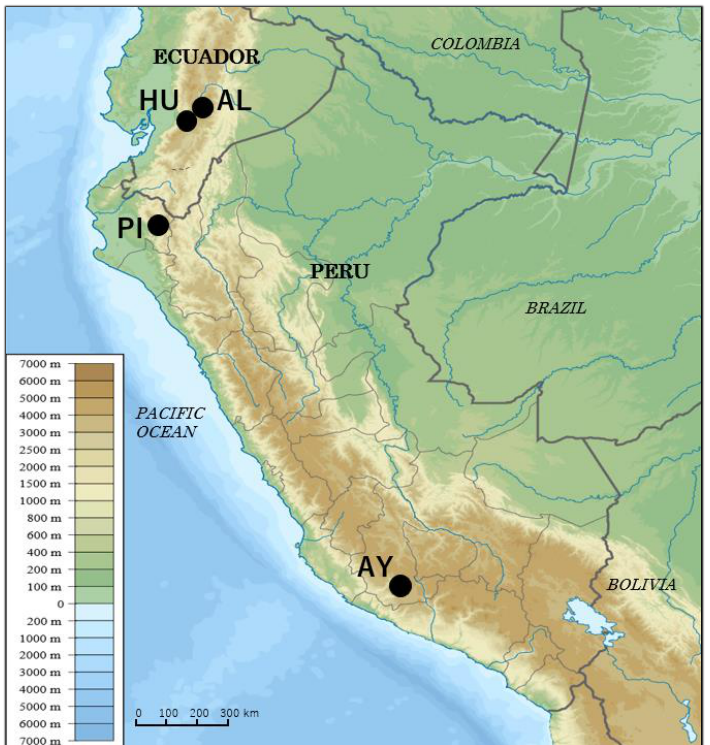
Figure 1. Map of Ecuador and Peru showing geographic locations at which Lutzomyia ayacuchensis were collected. AL, Alausi (2365 m altitude); HU, Huigra (1568 m altitude); PI, Huancabamba, Department of Piura (1938 m altitude); AY, Sancos, Department of Ayacucho (2819 m altitude). (Adapted from a map available at https://commons.wikimedia.org/wiki/File%3APeru_physical_map.svg).